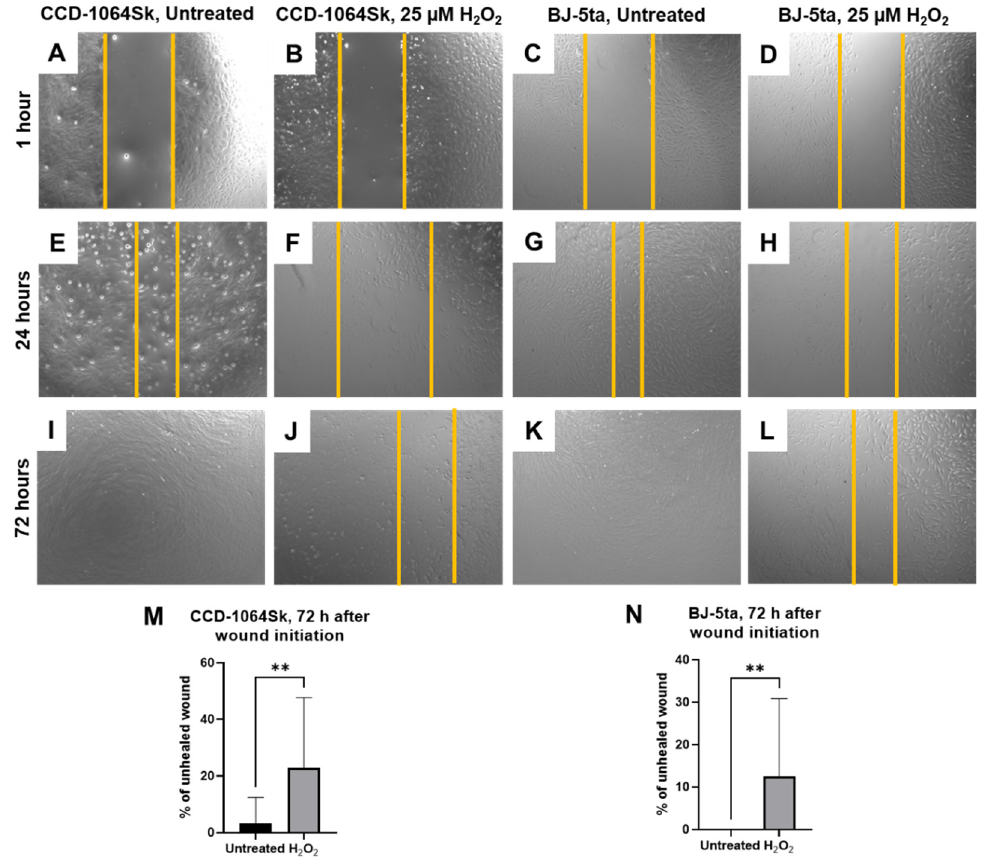
Figure 12. Regenerative ability of dermal fibroblasts estimated by wound-healing assay (one-step senescence model). Wound area in CCD-1064Sk, p.11 ( A , B ) and BJ-5ta, p.42 ( C , D ) one hour after single-time 25 μ M H 2 O 2 exposure. Decreased wound area in CCD-1064Sk, p.11 ( E , F ) and BJ-5ta, p.42 ( G , H ) 24 h after a single treatment of 25 μ M of H 2 O 2 . Wound closure in CCD-1064Sk, p.11 ( I , J ) and BJ-5ta, p.42 ( K , L ) 72 h after a single treatment of 25 μ M of H 2 O 2 . The percentage of the area of the wound that is not healed in CCD-1064Sk, p.11 ( M ) and BJ-5ta, p.42 ( N ) 72 h after single-time of 25 μ M H 2 O 2 exposure. Data were analyzed with a Student’s unpaired t-test for each separate parameter. **, p < 0.01. Bars represent mean ± SD.